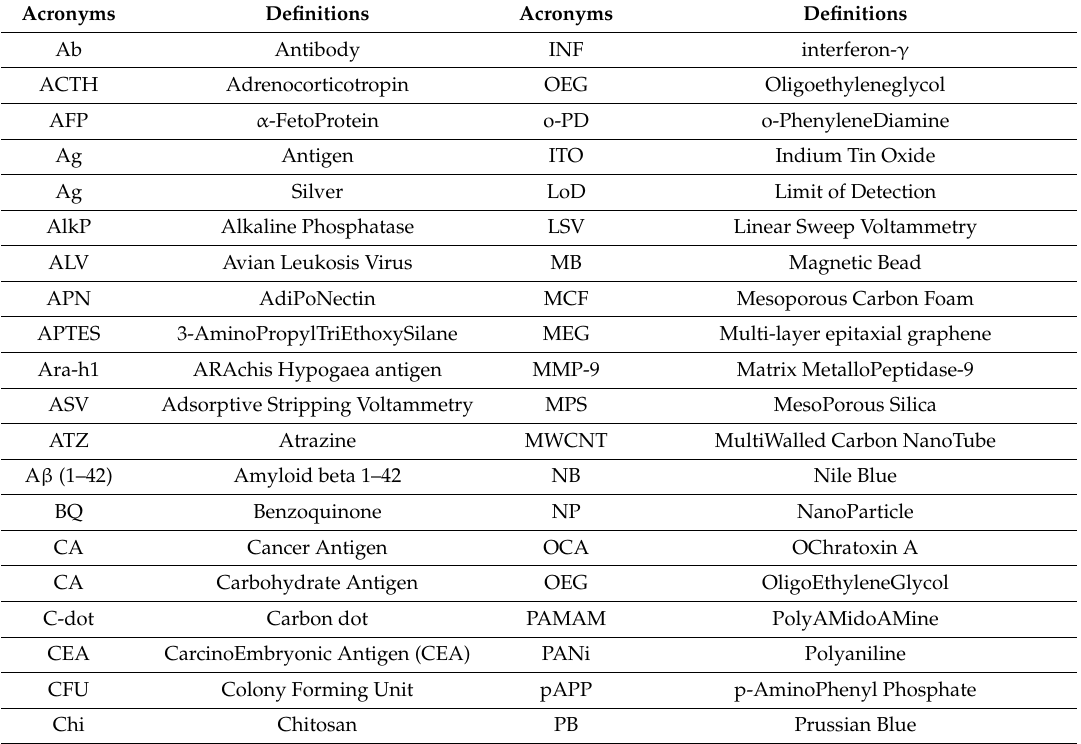
Table 1. Glossary of acronyms used in this